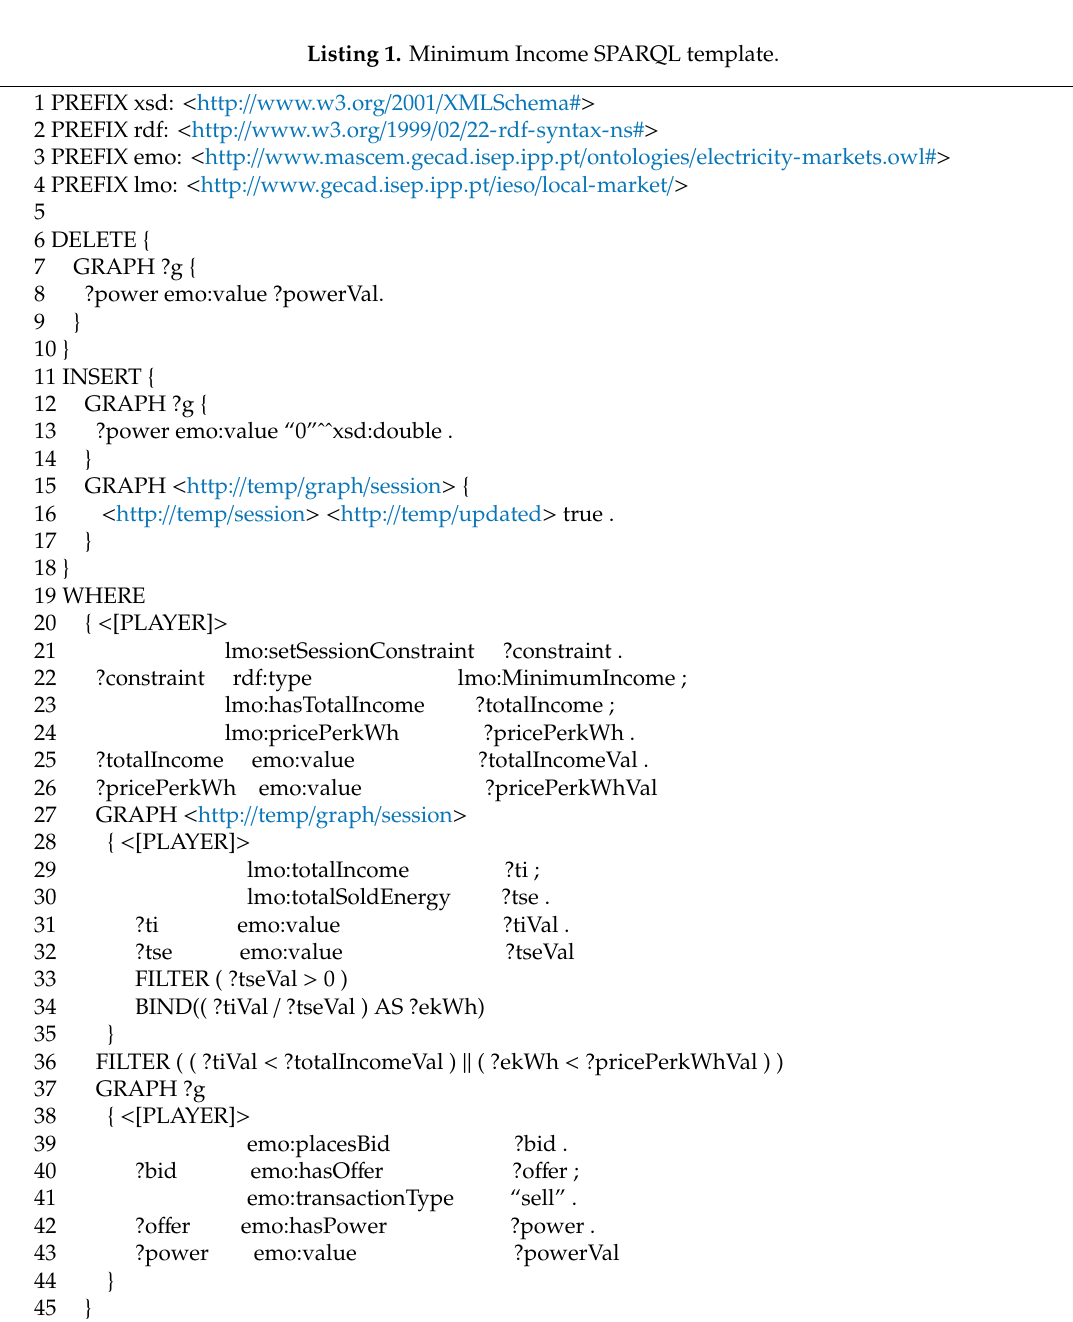
Listing 1. Minimum Income SPARQL